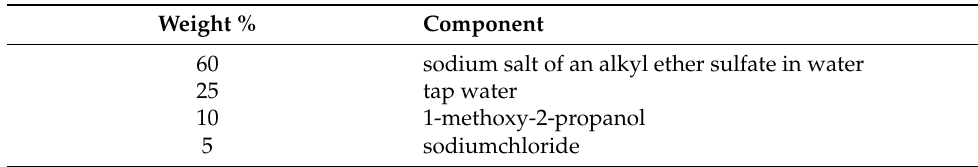
Table 2. Composition of the model liquid PFL-FR 2344 for plant protection products with indication in weight percent of their amount in the mixture [35,36].